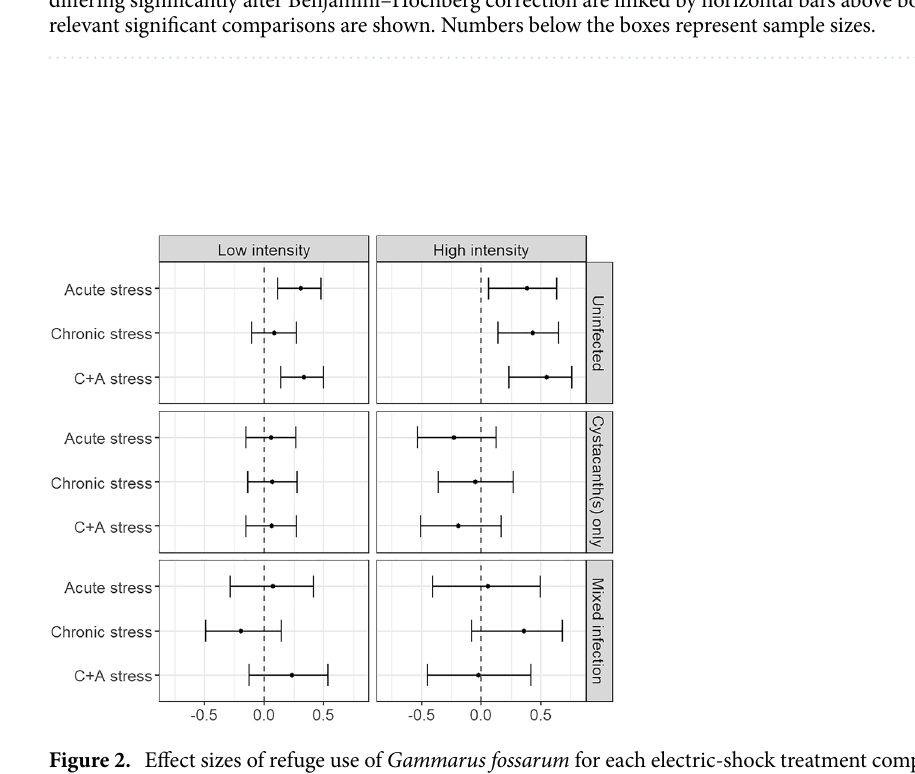
Figure 2. Effect sizes of refuge use of Gammarus fossarum for each electric-shock treatment compared to controls in both experiments, separated by infection statuses with Pomphorhynchus tereticollis . Points represent Cliff’s deltas and error bars represent confidence intervals. Positive values mean the focal group used the refuge more than controls of the same infection status, and negative values mean they used it less. C + A: “chronic and